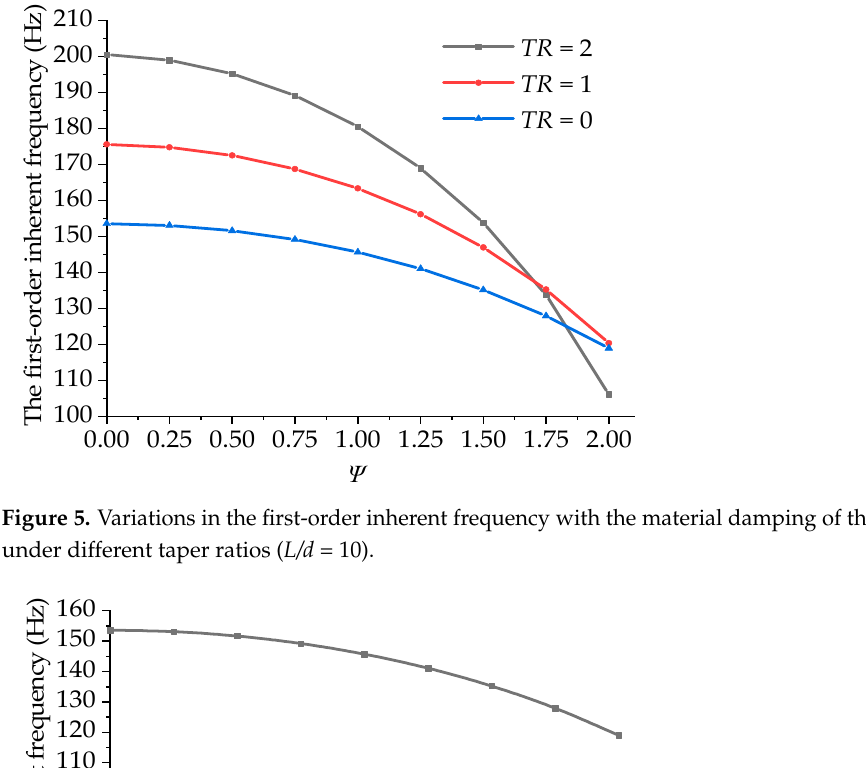
effects of both the taper ratio and damping should be